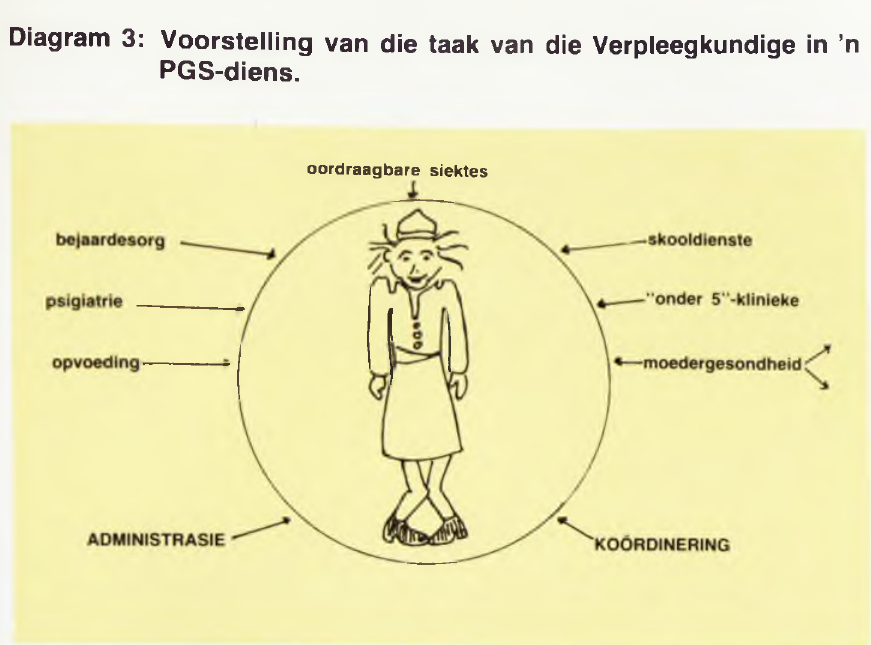
Diagram 3: Voorstelling van die taak van die Verpleegkundige in ’n